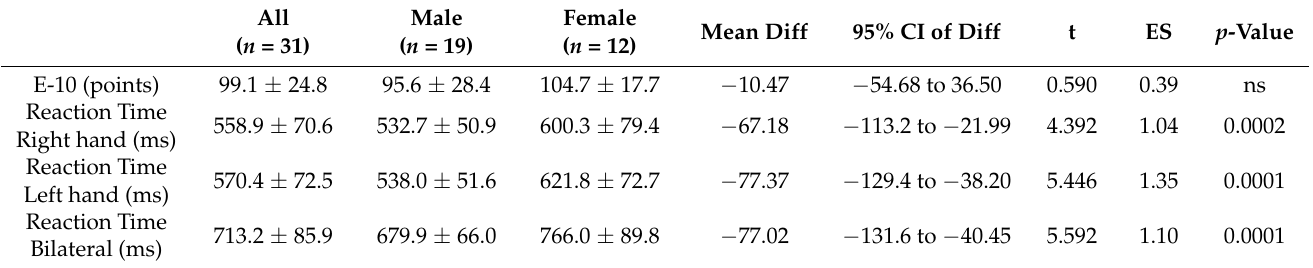
Table 2. Comparison of attention-concentration capacity and reaction time by